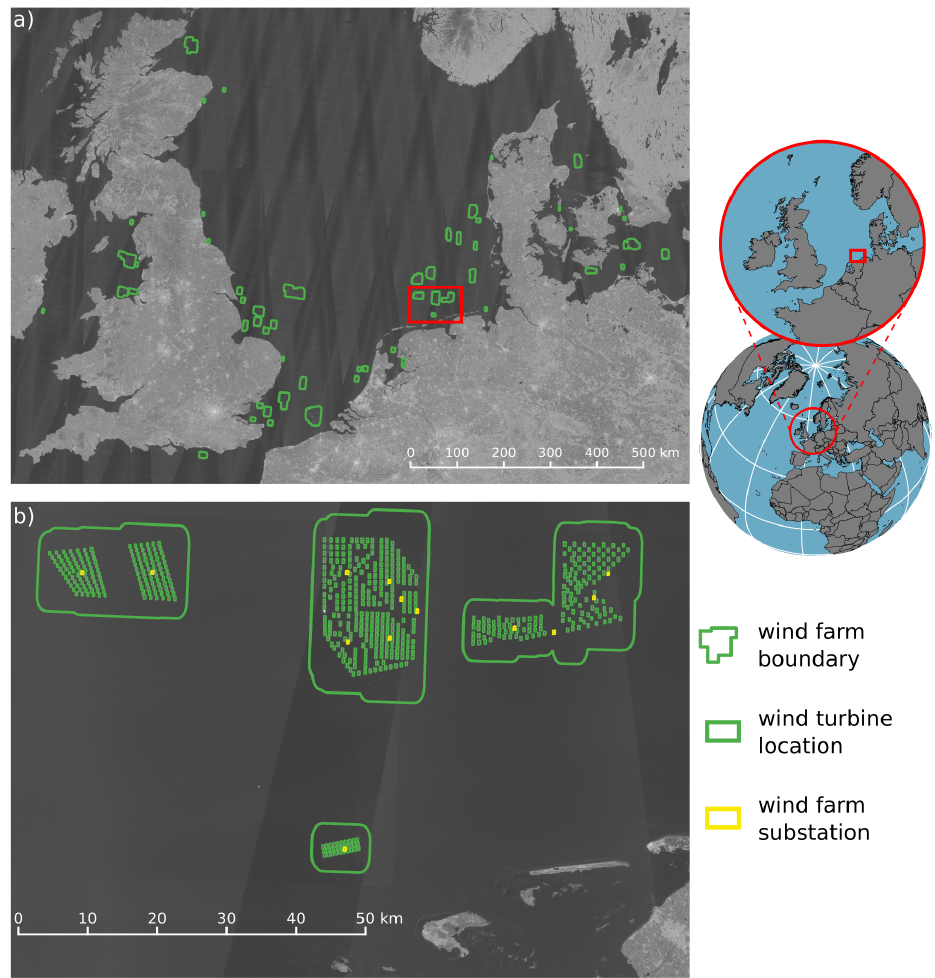
Figure 4. Detection results of the CNN cascade for the North Sea basin. Panel (a) shows the OWFs detected by stage 1, and panel (b) shows the OWT and OWF substations detected by stage 2 within the OWF boundaries of stage 1 in the German Bight. Table 1. Overview of all ground truth data sets, their corresponding timestamp, and the number of objects in each